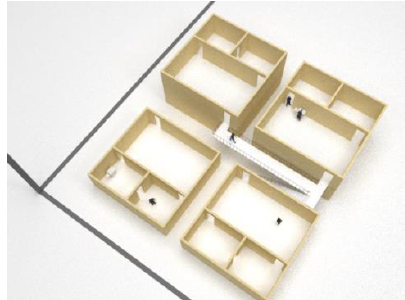
Figure 1. Indoor scene composed of 2 floors, 6 blocks (4 blocks on the ground floor), with each block containing 3 rooms. Two block on the ground floor and two blocks on the first floor are visible.